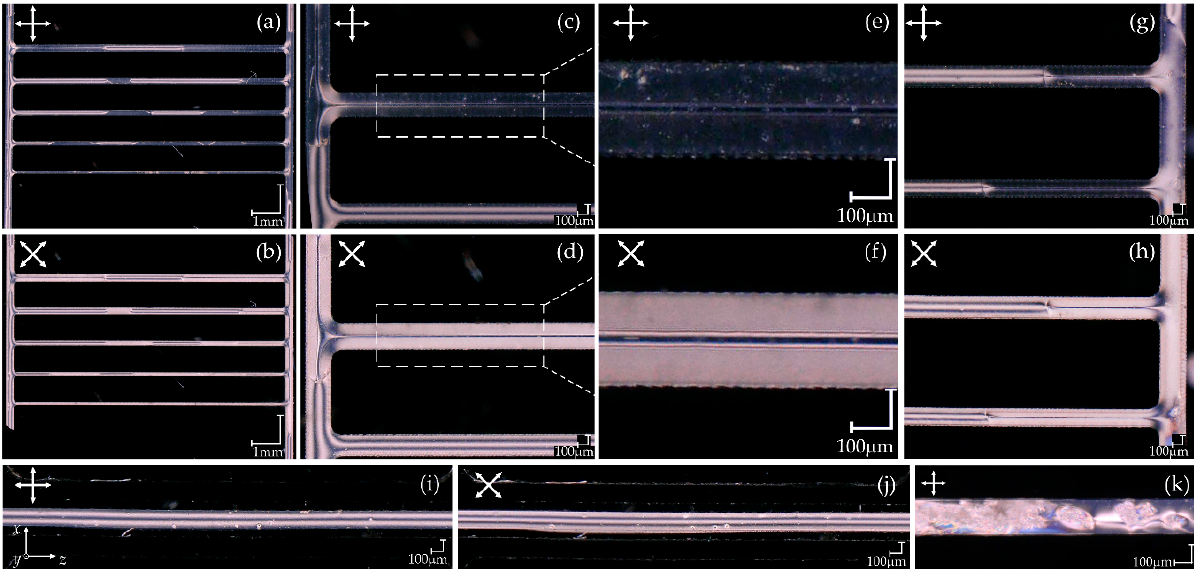
Figure 4. ( a – h ) POM images of the microstructures which were designed as the set of channels with different widths (from 50 to 250 µ m in steps of 50 µ m) and infiltrated with E7 NLC. The PDMS structures were fabricated using the mold micromilled in the PMMA material and then bonded with the substrate made of the PDMS layer ( a – f ) and the glass plate ( g , h ) The positioning of the samples with respect to the crossed polarizers is indicated in each photo. The zoom-in panels ( c – f ) show the middle right (i.e., channels with widths of 150 and 200 µ m) and top left (i.e., channels with widths of 200 and 250 µ m) parts of the structures, respectively. ( e , f ) Enlargements of the selected sections of the microchannels demonstrating the flow-induced orientation. ( i – k ) Images of a 200- µ m-wide single microchannel in the PDMS:glass architecture about one hour ( i , j ) and a few days ( k ) after infiltration.